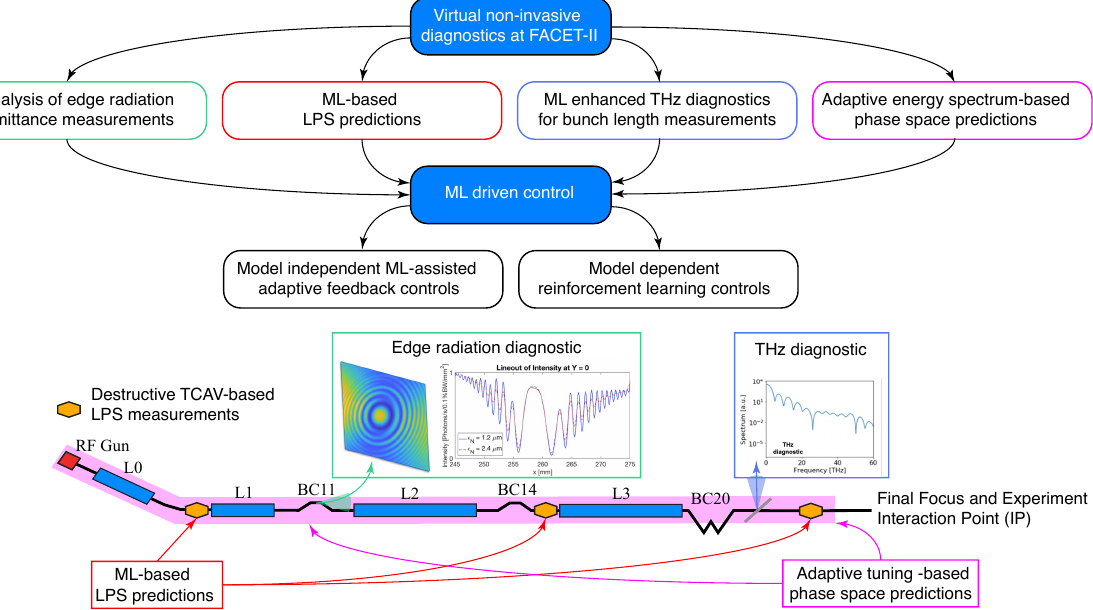
Figure 1. Schematic of the planned virtual diagnostic suite and ML driven controls at